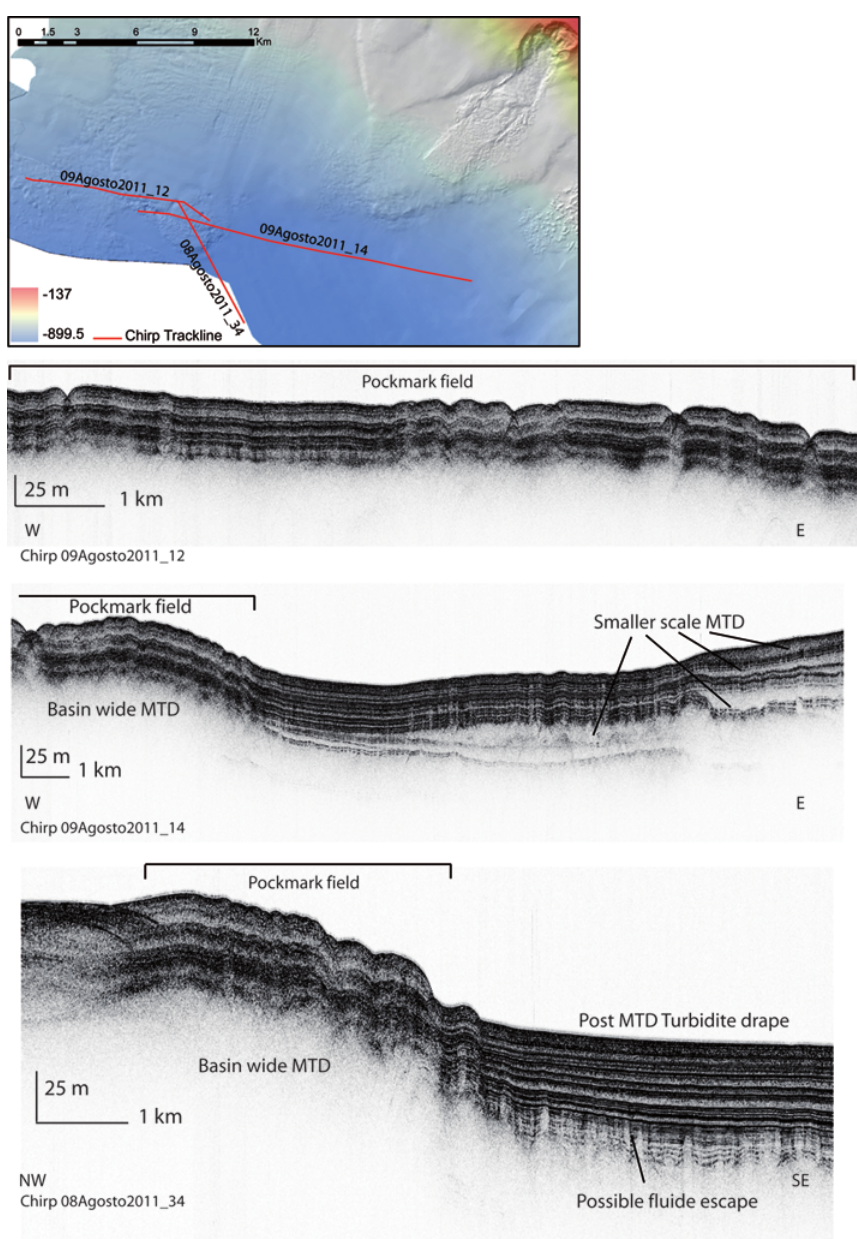
Fig. 6. Chirp sonar profiles across the pockmark-hosting morphologic bulge at the base of the slope showing the top of the last basin-wide mass-transport event (Gela slide?) and the thinning of plane-parallel reflectors (basin-plain fine-grained turbidites and hemipelagites) toward the bulge. Where thinner, this unit is likely easier to breach by the ascending fluids than in other